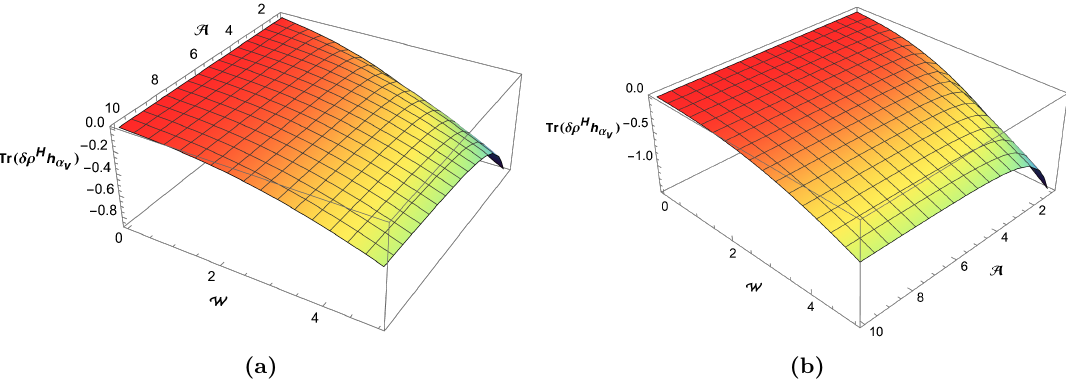
Figure 2. Initial state | a i for parallel motion: plots (a) and (b) show trace corresponding to work done by the system, Tr( δρ H h ) with respect to dimensionless acceleration of the primary detector α v ( A ) and dimensionless energy gap ( W ) of the composite system for α = 1 . 5 ), α a > 1 (here α a H H